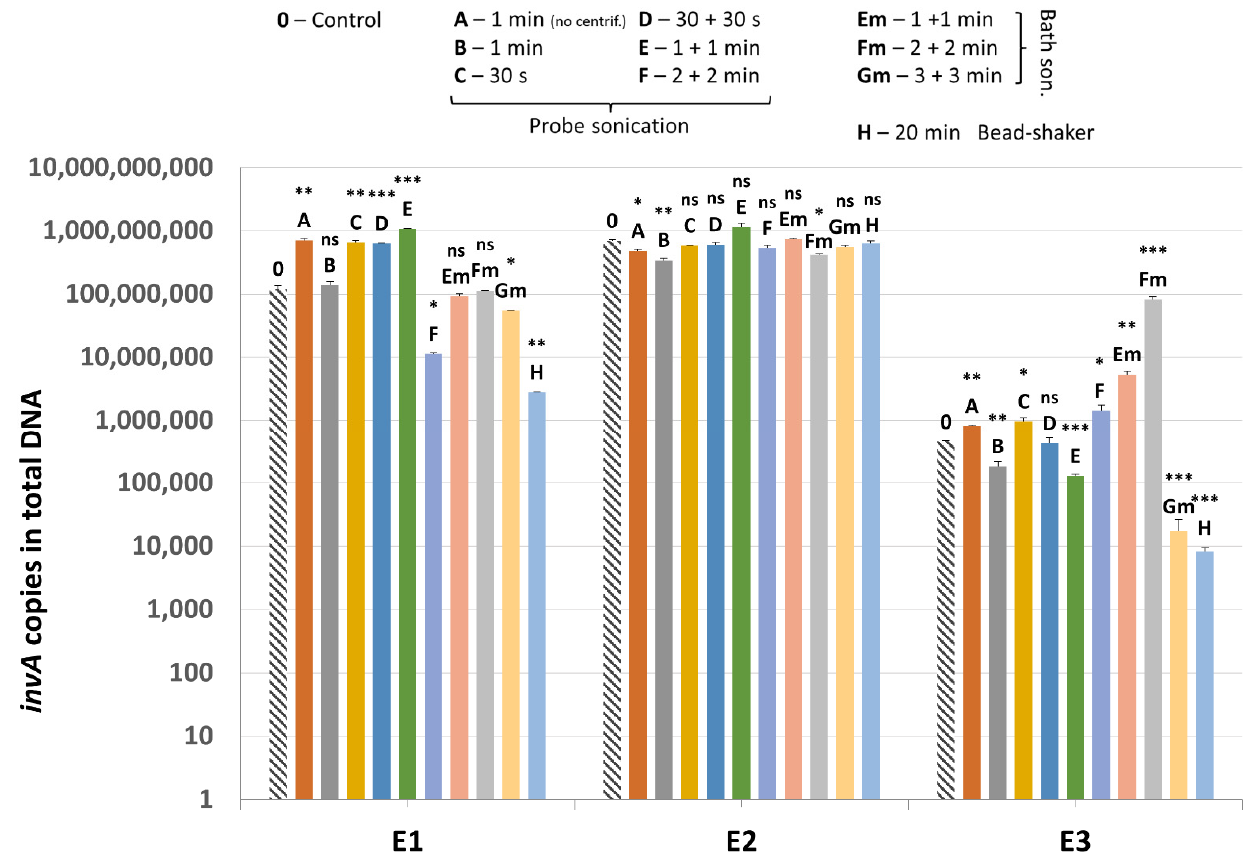
Figure 7. The quantification results of invA (IC2) in samples E1–E3. Statistical significance